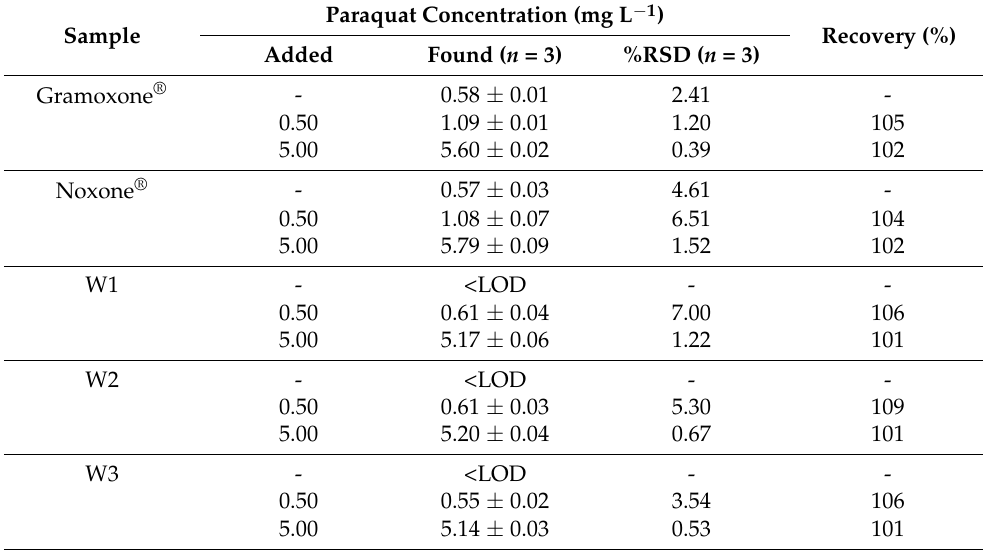
Table 3. Paraquat concentrations and recovery studies found in samples using our developed test